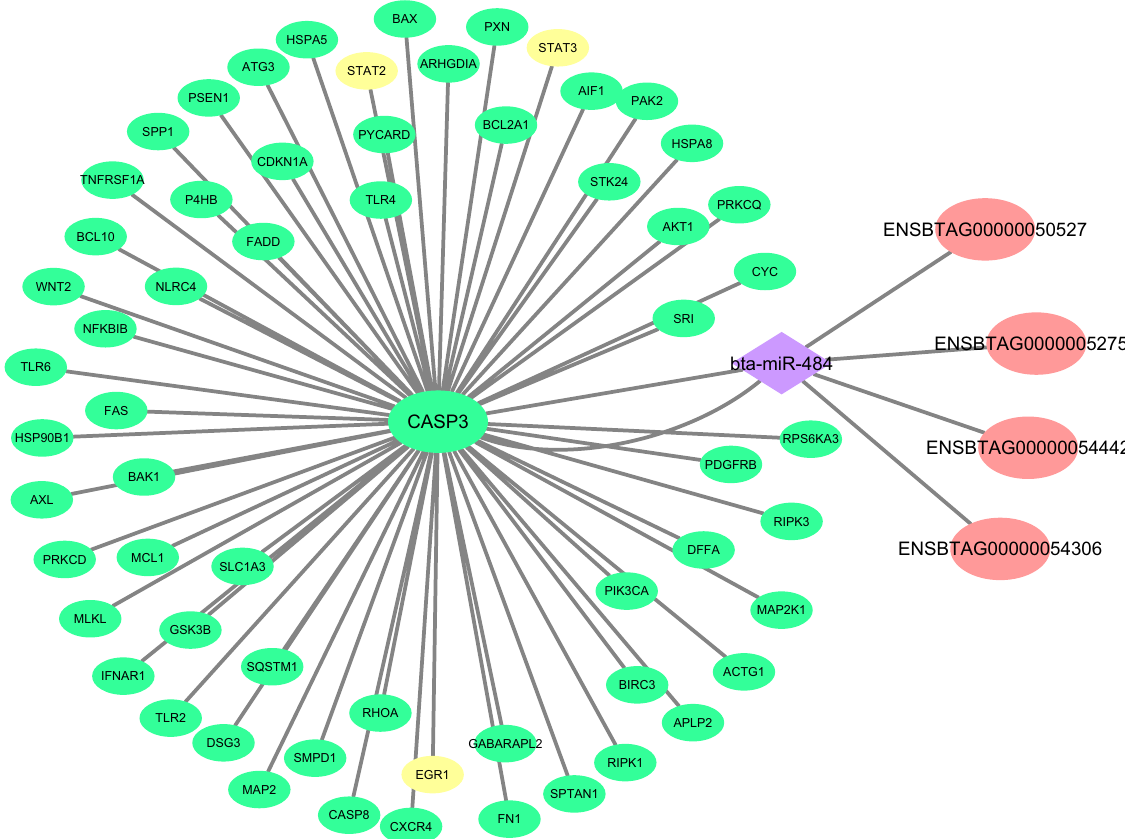
Figure 9. The constructed integrated regulatory sub-network related to CASP3 in turquoise Rb-module. The green and yellow circles indicate hub genes and hub TFs related to casp3, respectively. The purple diamond represents hub miRNA that be predicted to regulate CASP3 and hub-hub lncRNAs including ENSBTAG00000050527 , ENSBTAG00000052755 and ENSBTAG00000054306 . Cytoscape software (version 3.7.2) (https:// cytos cape. org/) was used to generate this